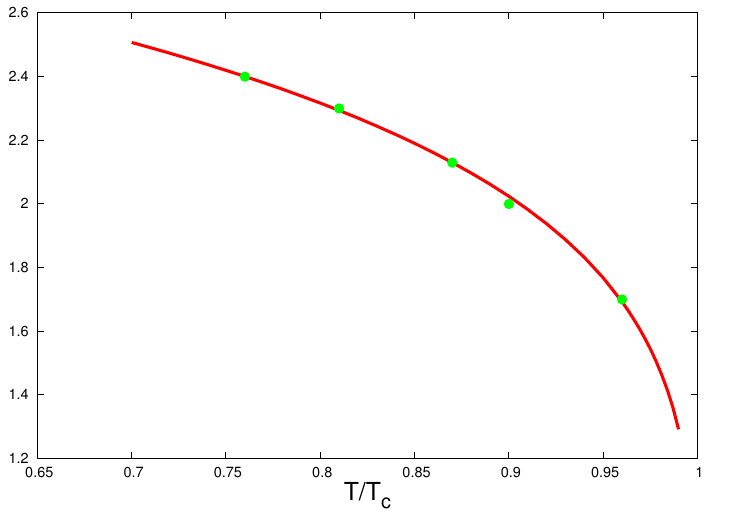
√ σ 0 R s.b. vs. the fitting function 3.171